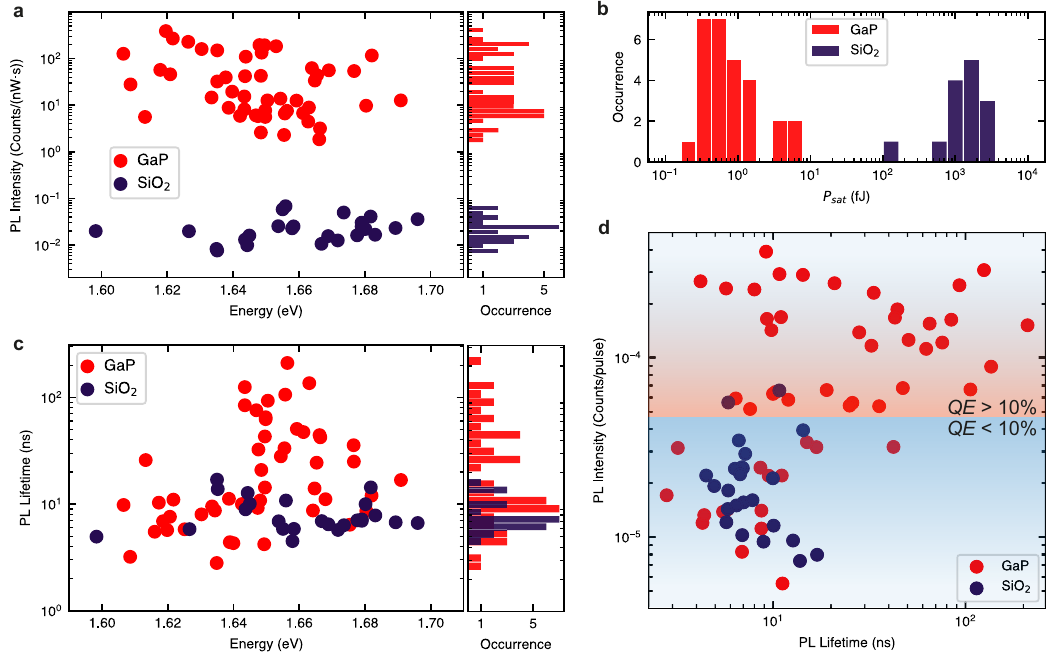
Fig. 2 Comparison of optical properties of SPEs formed on GaP dimer nanoantennas and on SiO 2 nanopillars. Data for SPEs on GaP dimer nanoantennas are shown in red and for SPEs on SiO 2 nanopillars is shown in dark blue. a PL intensity normalized by the average laser excitation power measured in the SPE saturation regime. The histogram on the right shows the occurrence of the observed PL intensity values. b Energy per laser pulse required for SPE saturation, P sat . See Supplementary Fig. 4 for more details on how P sat is extracted from the PL data. c PL decay times (main plot) and its occurrence (right). d SPE PL peak intensity divided by the laser repetition rate plotted versus SPE PL decay time. The red and blue areas of the plot correspond to SPEs with QE > 10% and QE < 10%, respectively. See main text and Supplementary Note VI for more details of how QE was